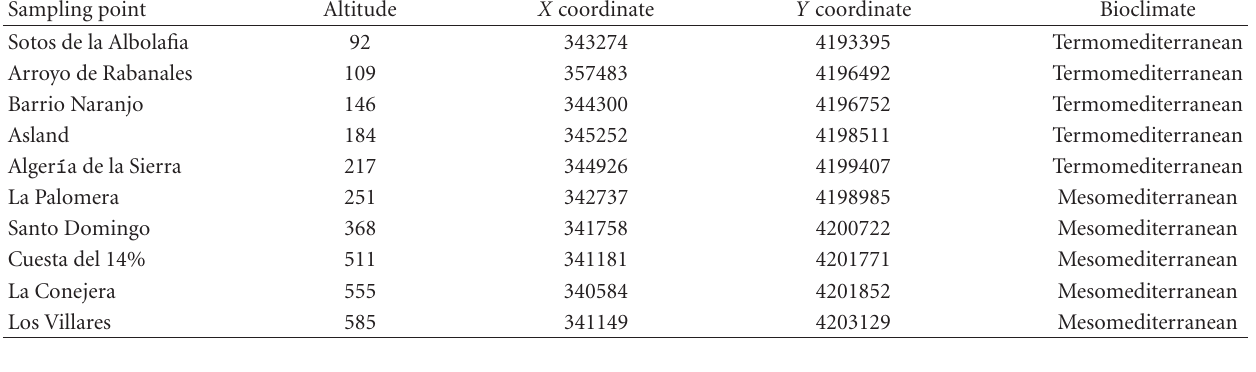
Table 1: Sampling points coordinates.